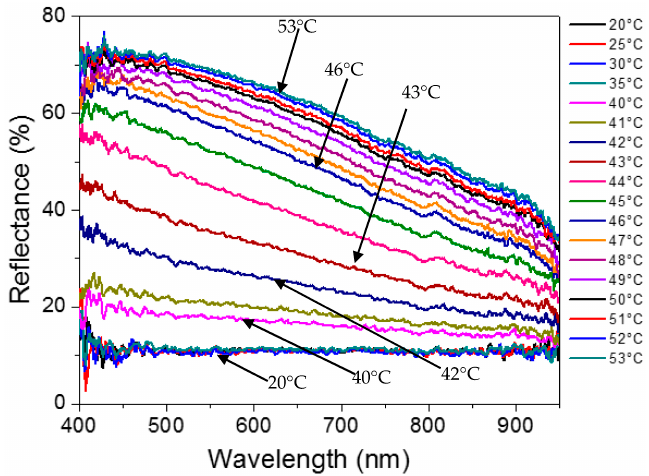
Figure 7. The reflectance of 6 wt. % HPC in aqueous solution under various temperature conditions. Energies 2017 , 10 , 1889 Upon increasing HPC concentration in aqueous solution from 1 wt. % up to 6 wt. % HPC, reflectance was also observed to increase, as can be seen in Figure 8.